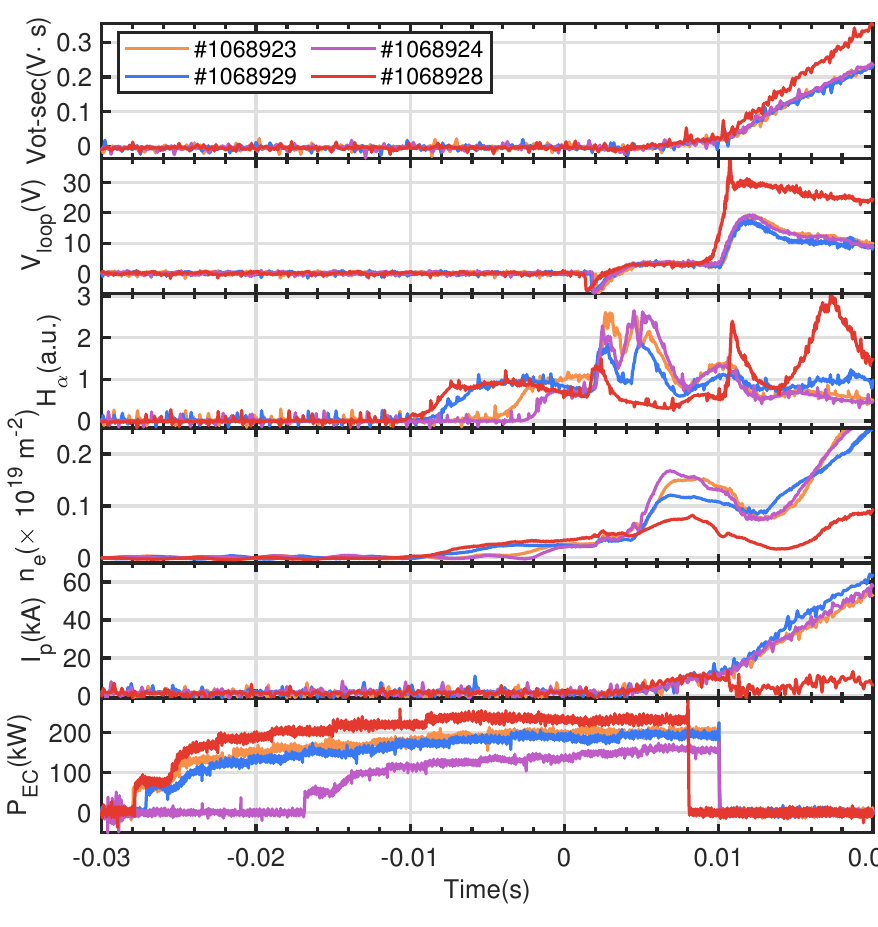
Figure 6. Evolution of key signals for di ff erent ECH